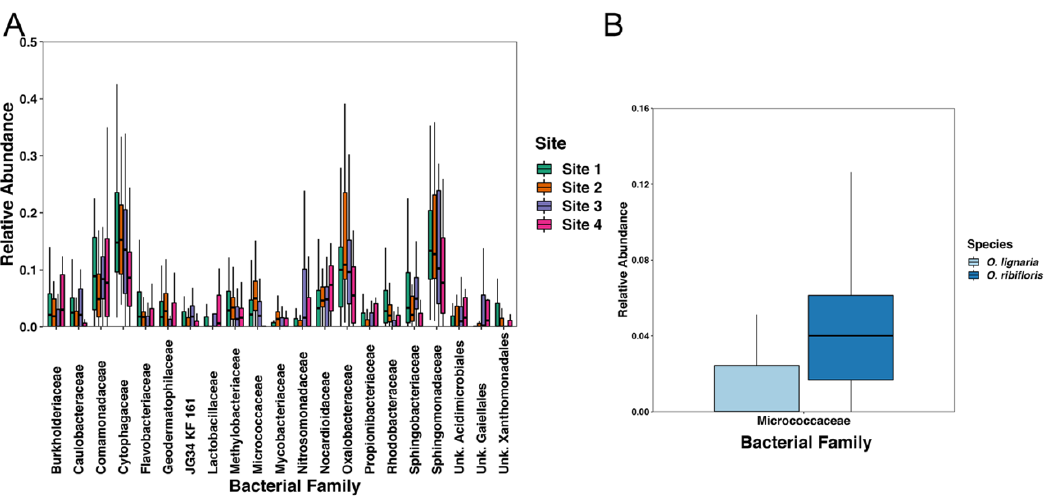
Figure 6. Boxplots of the average relative abundances of bacterial families (present at greater than 0.5% relative abundance) that were significantly differentially abundant as measured by ANCOM (Wald > 1 for each family) between ( A ) sampling locations and ( B ) Osmia species. Whiskers represent 1.5 × the interquartile range of the data.